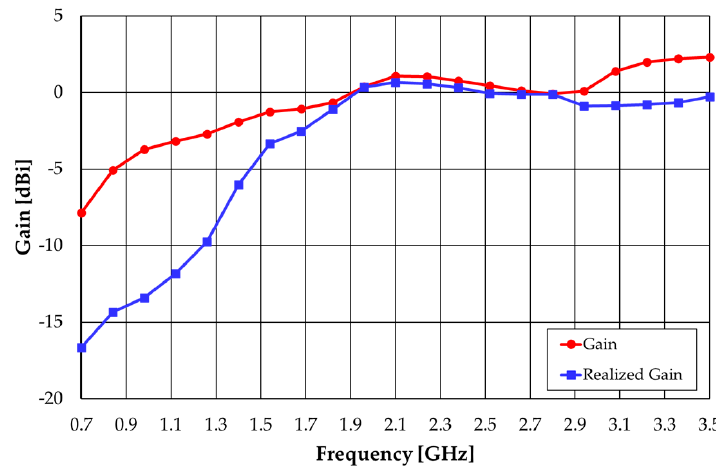
Figure 5. CST simulated gain results of the straight monopole. The CST simulation results of the Z-component of the surface current distribution along the monopole are shown in Figure 6. These results agree with the sinusoidal distribu- tion approximation of the thin wire dipole/monopole [10]. Moreover, the current at the end of the monopole (Z = 25 mm) does not vanish due to the fringing effect, which is more effective as frequency increases.